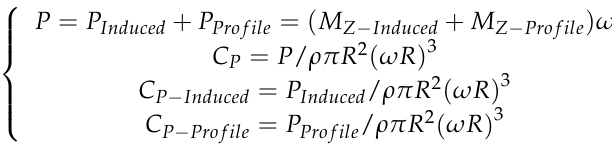
Figure 6. Comparison of the prediction result and flight test data. Four flight conditions are considered in this study to investigate the generalizability of segment twist control configuration for ATR in rotor power reduction, as shown in Table 2. The weight coefficients of 0.0065 and 0.0083 are determined, representing the typ- ical-thrust flight condition and the medium-thrust flight condition, respectively. The ad- vanced ratios of 0.25 and 0.35 are selected to represent the cruise flight condition and the high-speed flight condition, respectively. Table 2. Summary of flight conditions. Condition